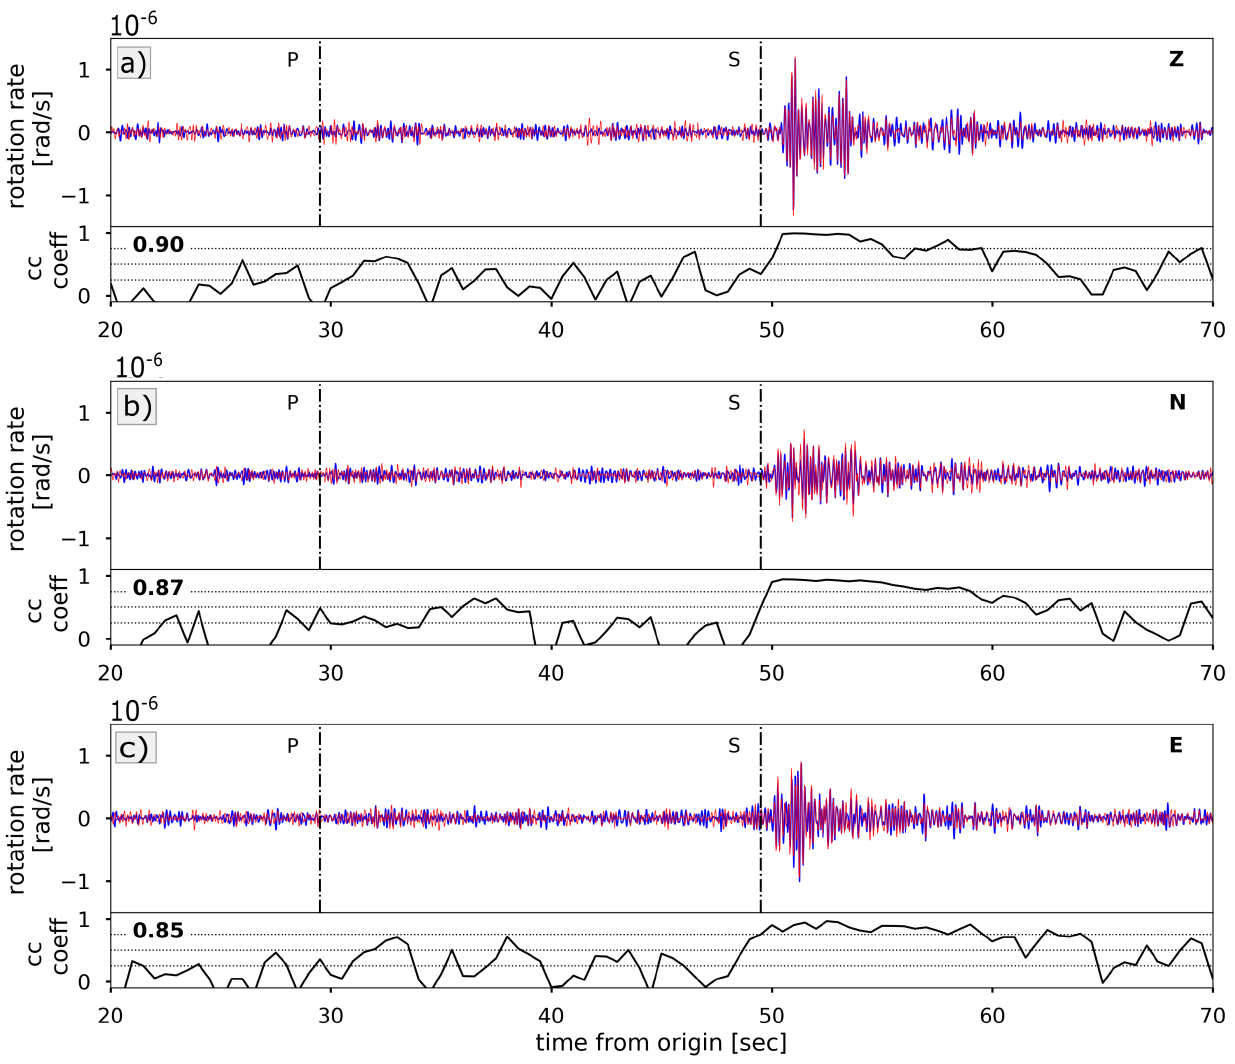
Figure 12. Component-wise cross-correlation between rotational sensors XBLUE (blue) and XB101 (red). Data are filtered between 3 and 9 Hz and analysed in a sliding window of 1s length with 50% overlap. Vertical dotted lines mark the onsets of the P- and S-wave. ( a – c ) show the correlation coefficient over time for each component. The average value for all coefficients greater than 0.75 is given in the upper left corner. For other sensor combinations results are summarised in